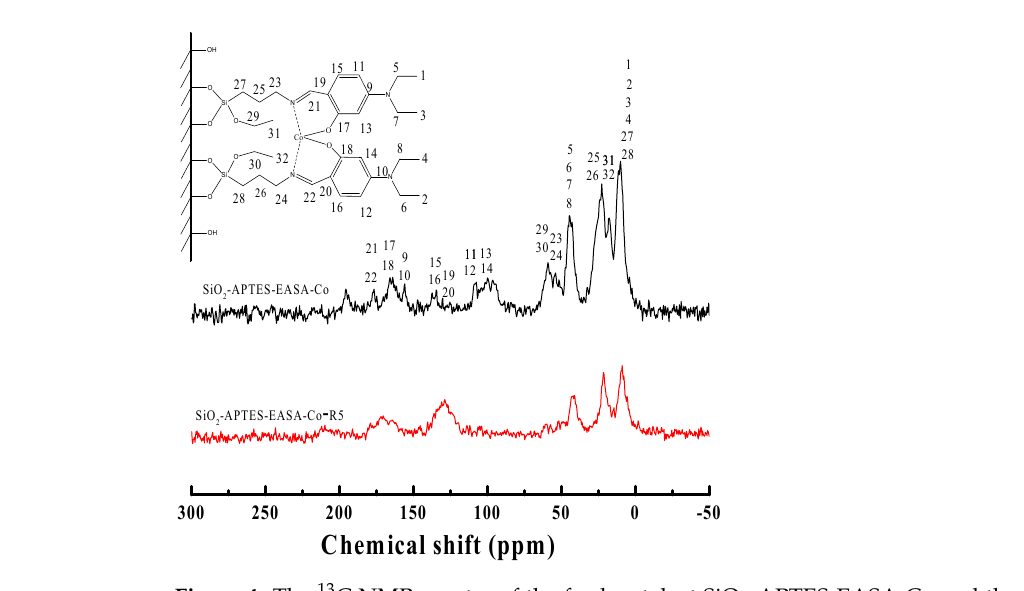
( B ) Figure 6. Co 2p XP spectra of the fresh (a) and the spent (b) SiO 2 ‐ APTES ‐ EASA ‐ Co catalysts ( A ) in comparison with the Co 2p XP spectrum in Co(acac) 2 ( B ). 2.4. Catalytic Performance The covalently anchored Co ‐ Schiff base catalysts synthesized were tested via toluene oxidation under solvent ‐ free conditions using molecular oxygen, and the results are sum ‐ marized in Table 3. It is clear that the synthesized catalysts are active for the transfor ‐ mation from toluene to its oxofunctionalization products, and the discrepancy in catalytic